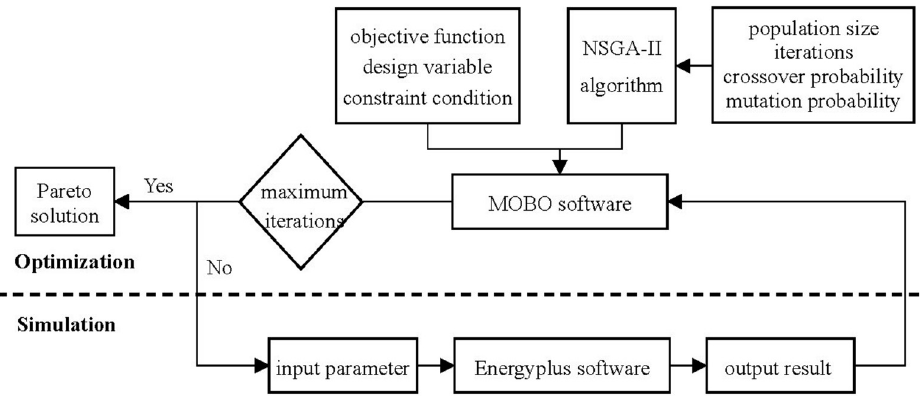
Figure 5. Optimization process by coupling EnergyPlus and MOBO